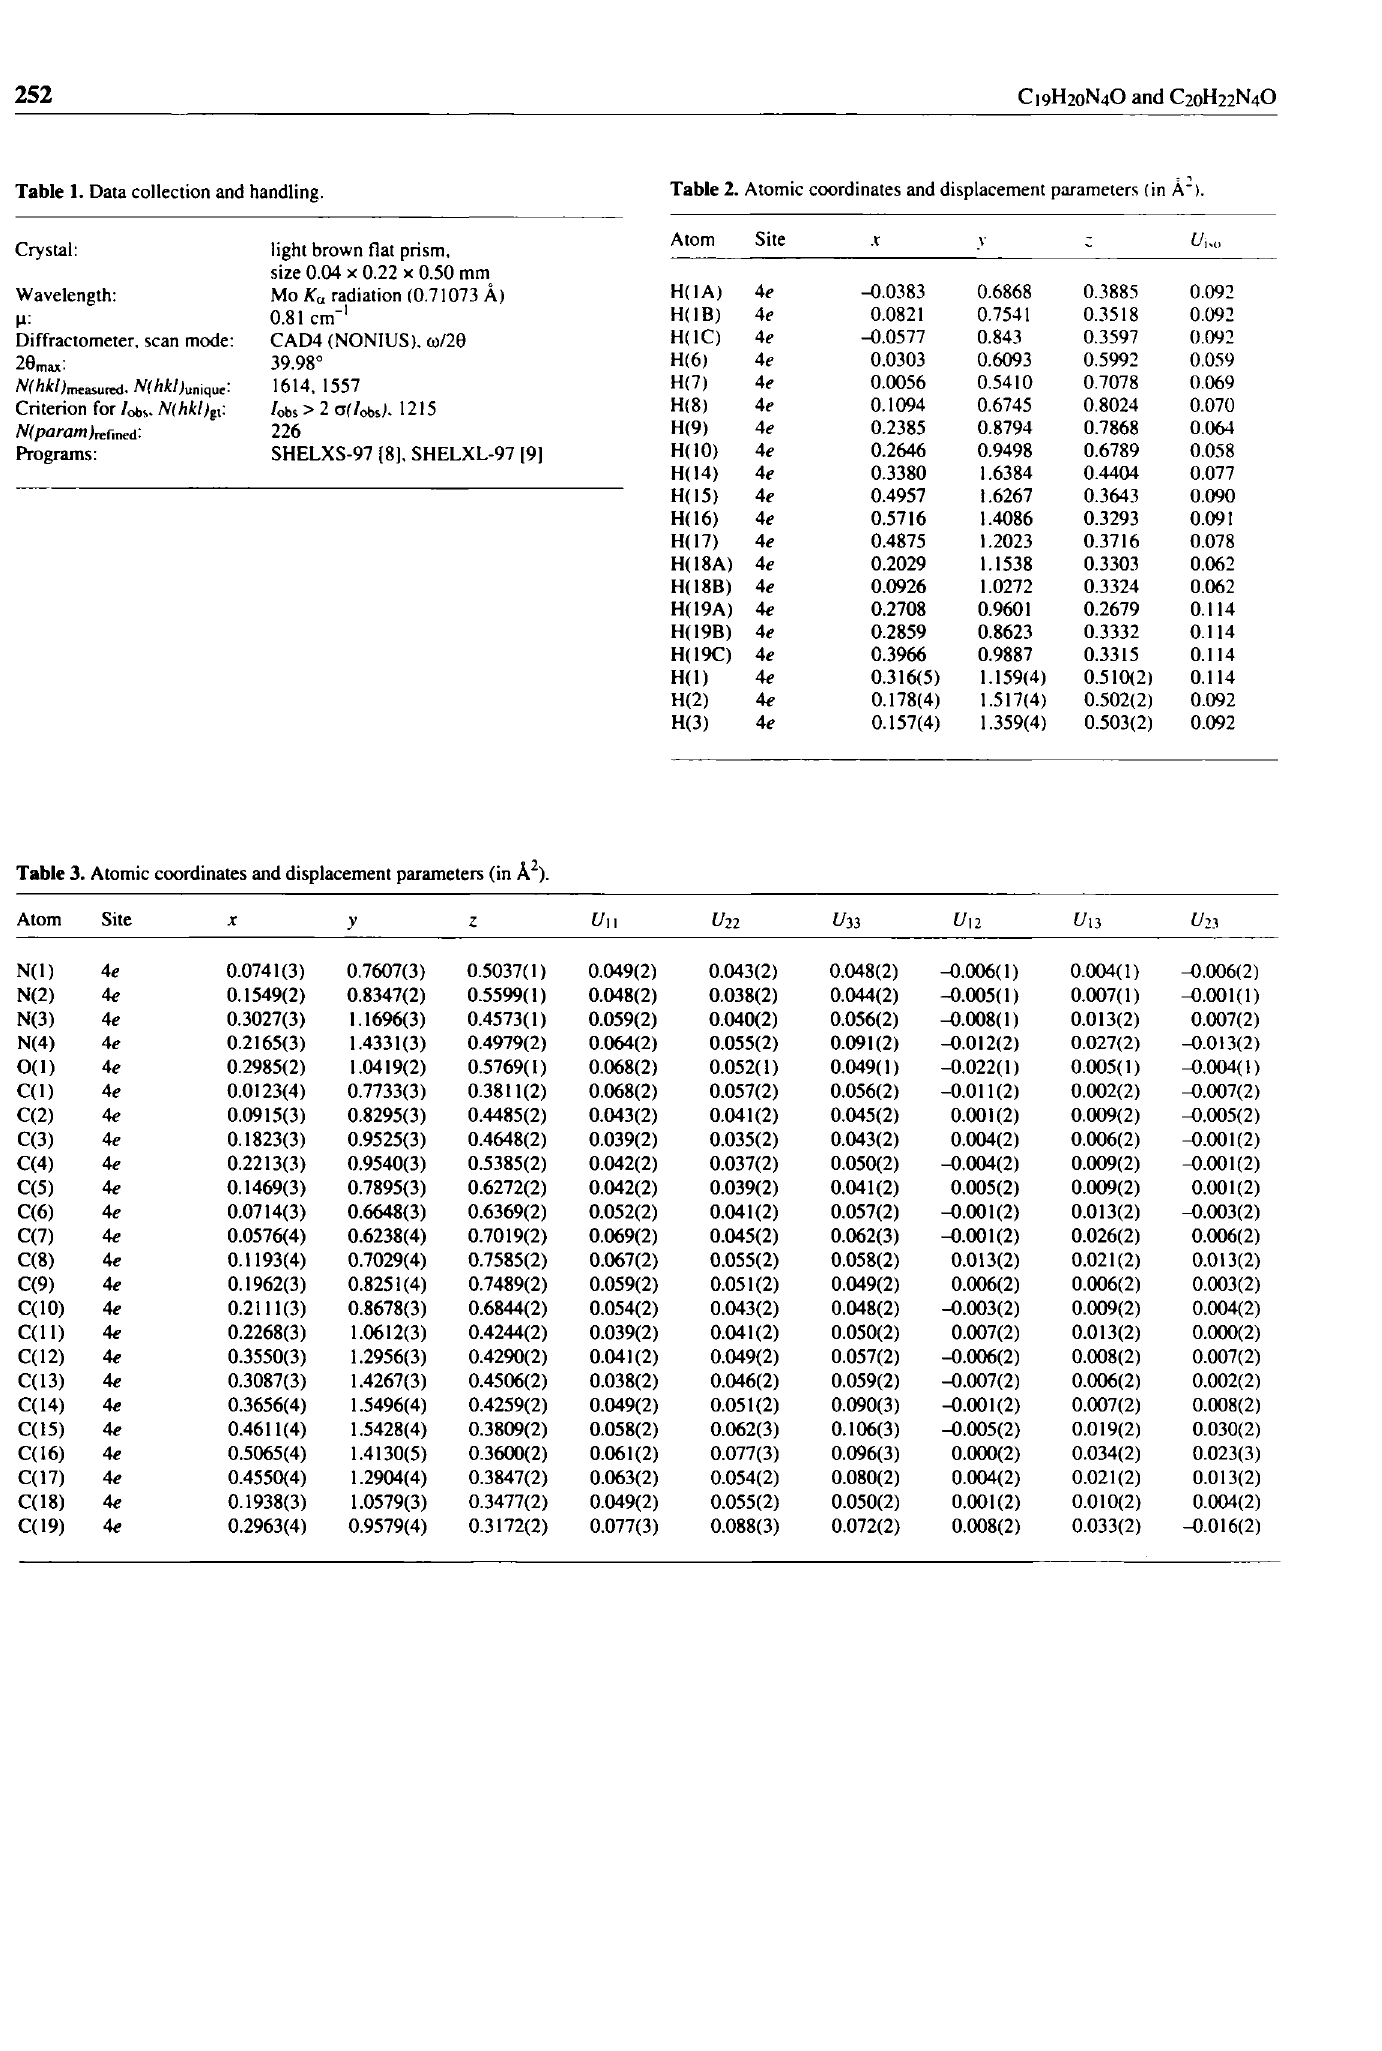
Table 3. Atomic coordinates and displacement parameters (in A 2